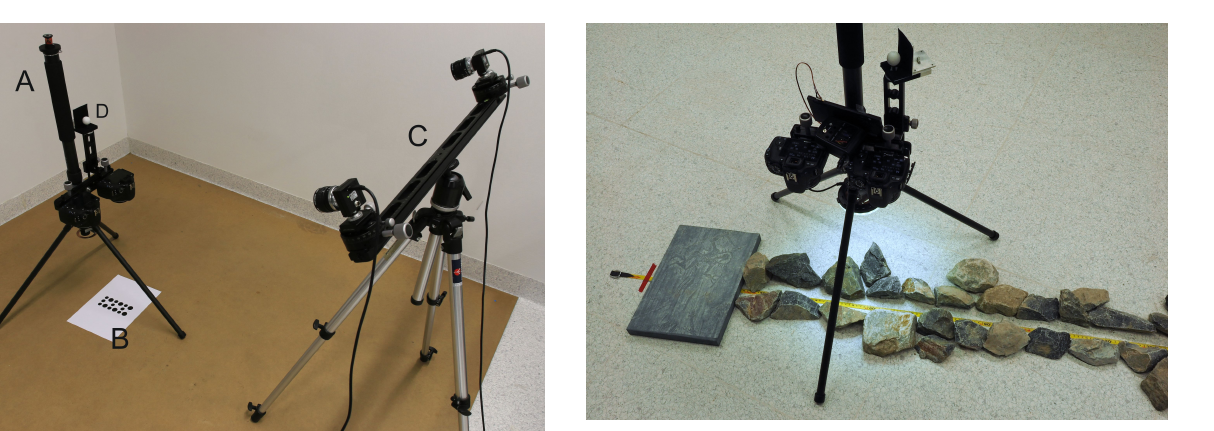
Figure 11: Application of the scanner to test scene II using LED lighting attached to the scanner in-between the cameras in order to achieve a nearly diffuse local illumination of the scene.